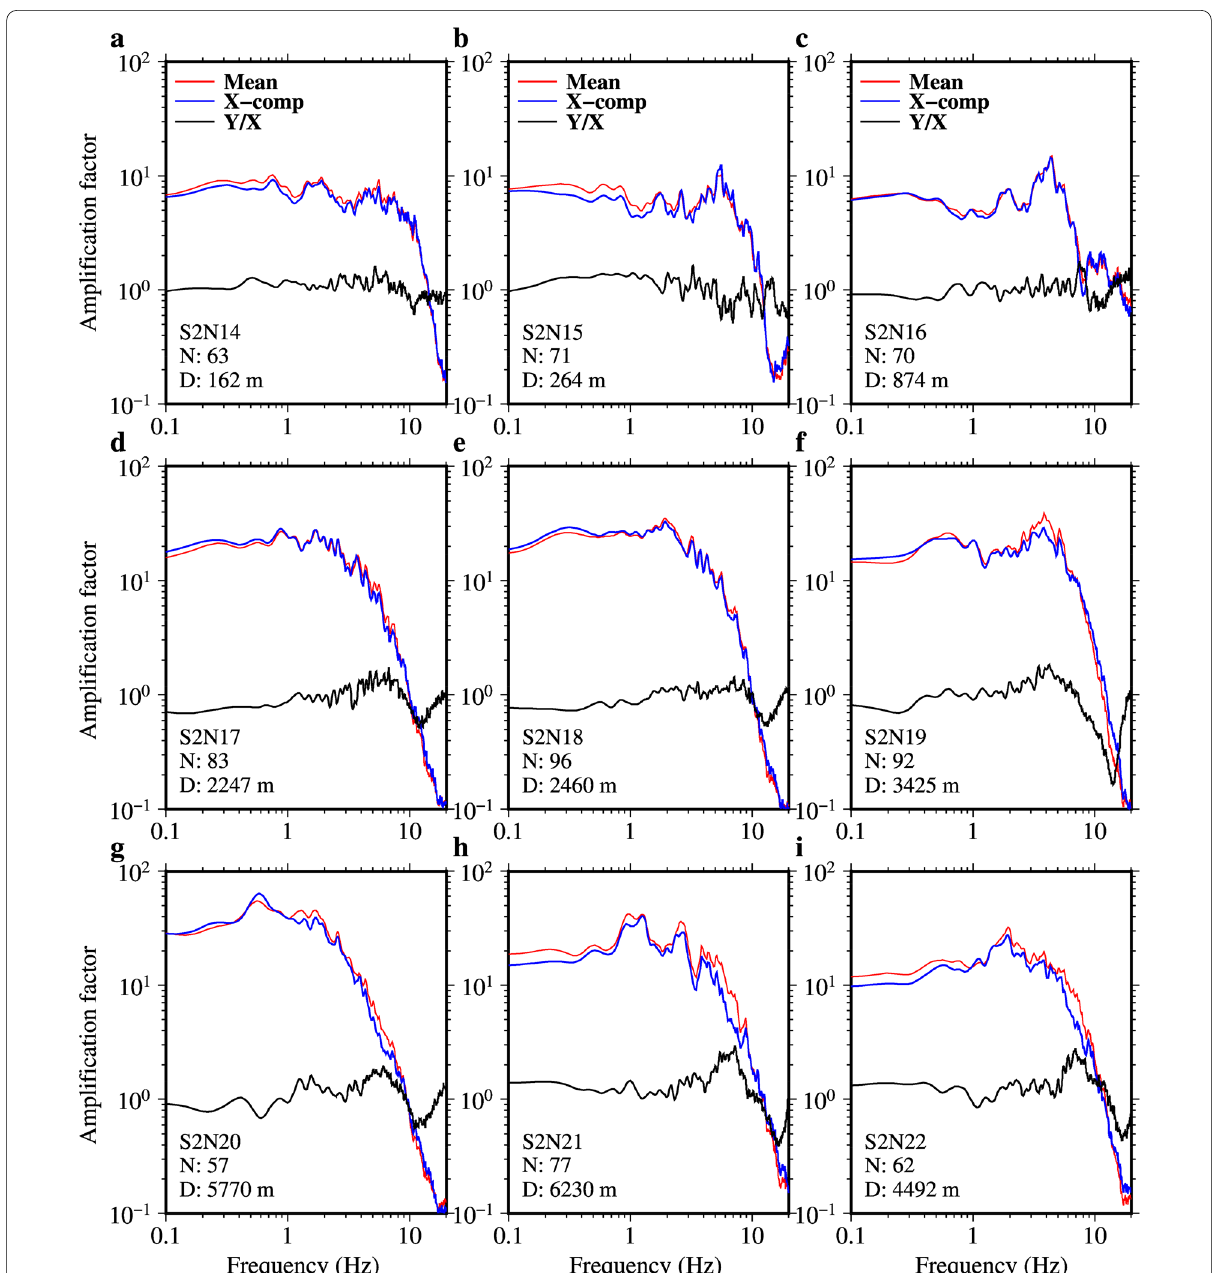
Fig. 12 Example comparison of the site spectra obtained from the spectral inversions of mean spectra of X- and Y-component records (red lines) and spectra of X-component records (blue lines). The plots a , b , c , d , e , f , g , h , and i correspond to sites, namely, S2N14, S2N15, S2N16, S2N17, S2N18, S2N19, S2N20, S2N21, and S2N22, as indicated in each panel. See Fig. 11 for the location of the sites. The black lines denote the mean spectral ratios between the horizontal Y- and X-component records. The number of earthquake records (N) used for each site and the depth to the seafloor (D) are indicated in each